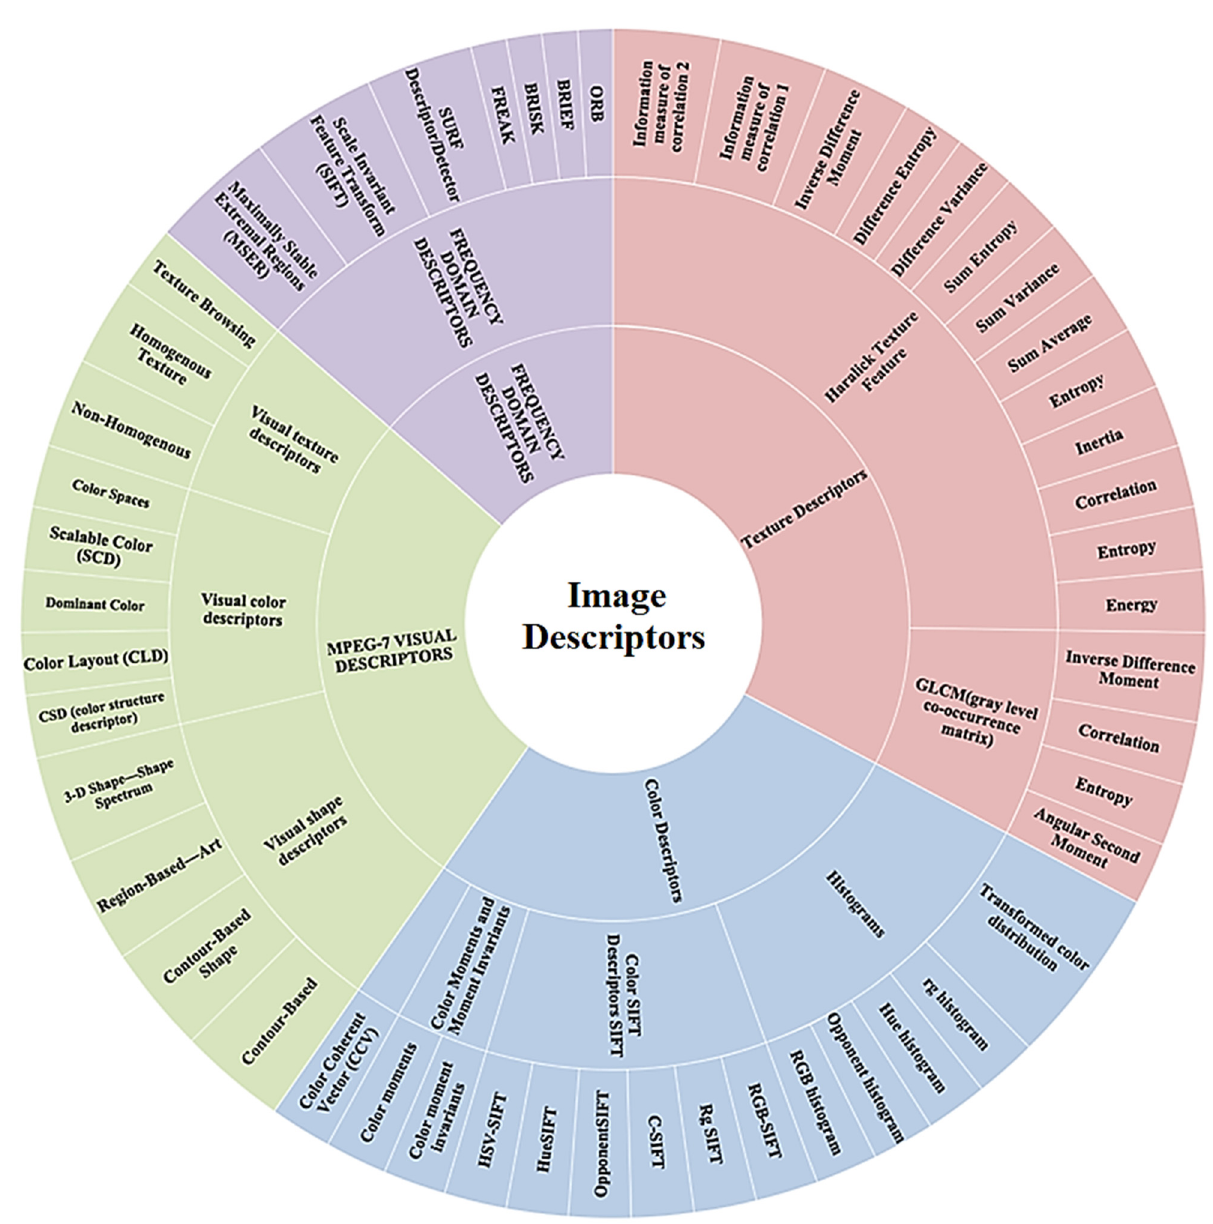
Figure 1. Common descriptors stated in the literature.